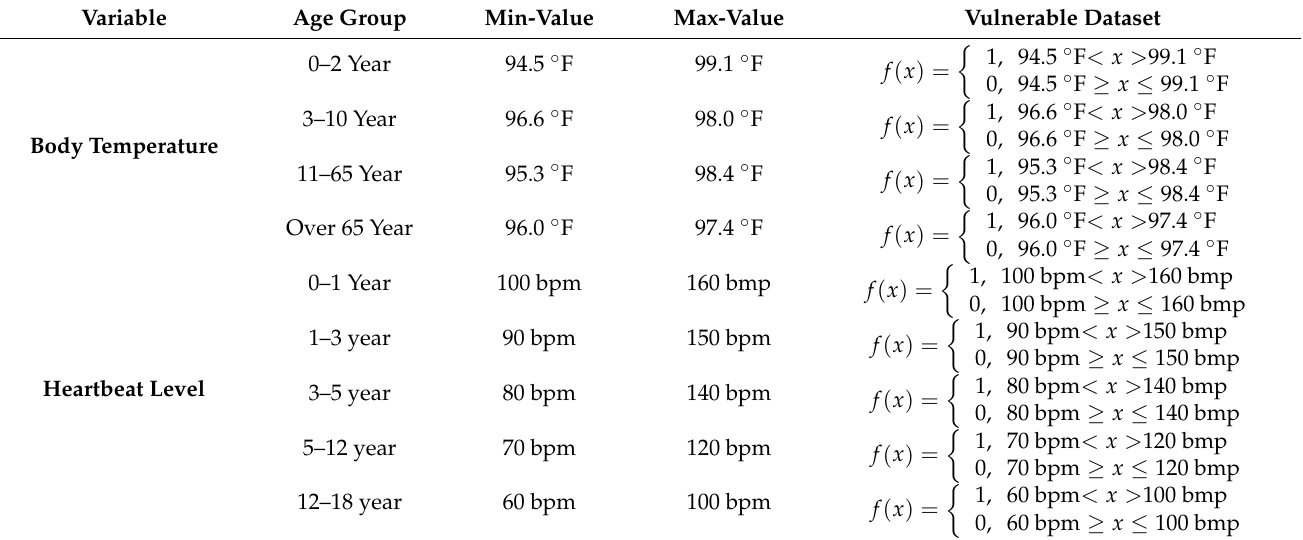
Table 4. The SoTL table for body temperature and heartbeat level under the Stakeholder Fitness Dataset (SFD). f ( x ) = 0 Indicates an invulnerable state and f ( x ) = 1 indicates a vulnerable